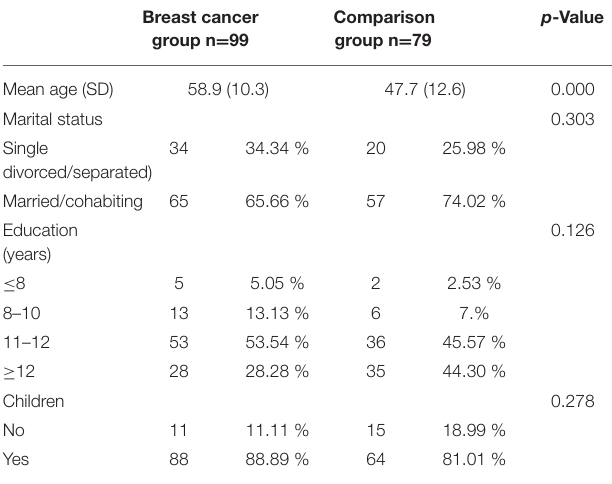
TABLE 1 | Sociodemographic characteristic of